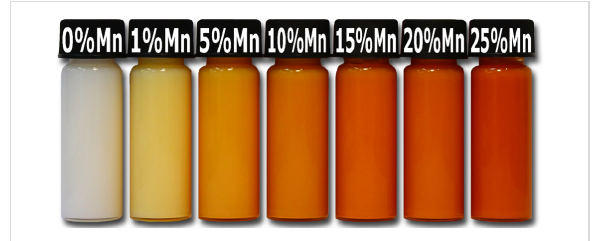
Figure 9: Visual comparison of changes in colours of suspensions of Zn 1 − x Mn x O NPs depending on the dopant content.